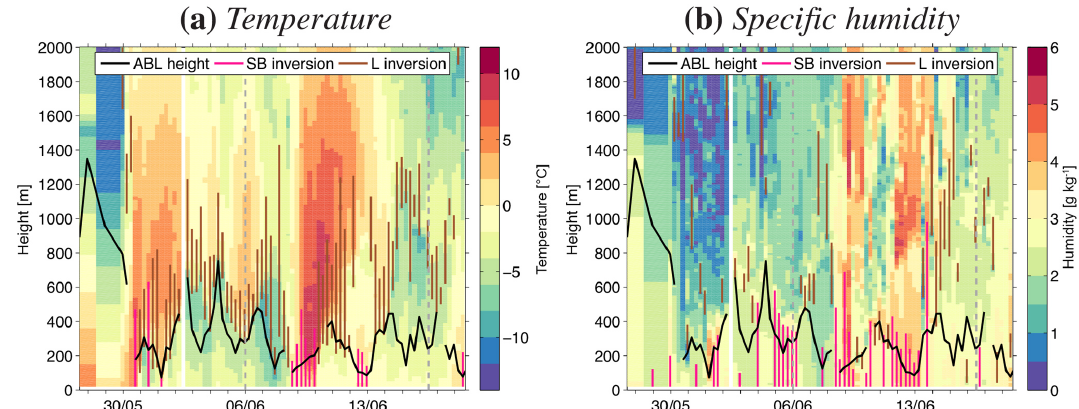
Figure 5. Vertical profiles of (a) temperature and (b) specific humidity measured at Polarstern over the PASCAL measurement period (28 May–18 June 2017). Pink and brown vertical lines indicate the vertical extent of the lowermost surface-based (SB) and lifted (L) inversions, respectively, while black contour lines indicate the atmospheric boundary layer (ABL) height corresponding to the blue circles in Fig. 4. Dashed vertical lines distinguish the Polarstern ocean-crossing periods from the ice-attached period (6–16